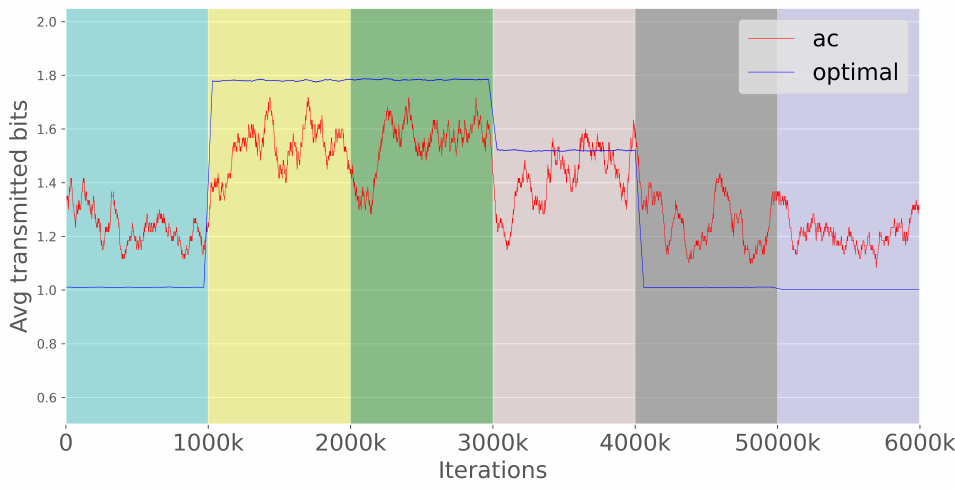
Figure 8. Bandwidth